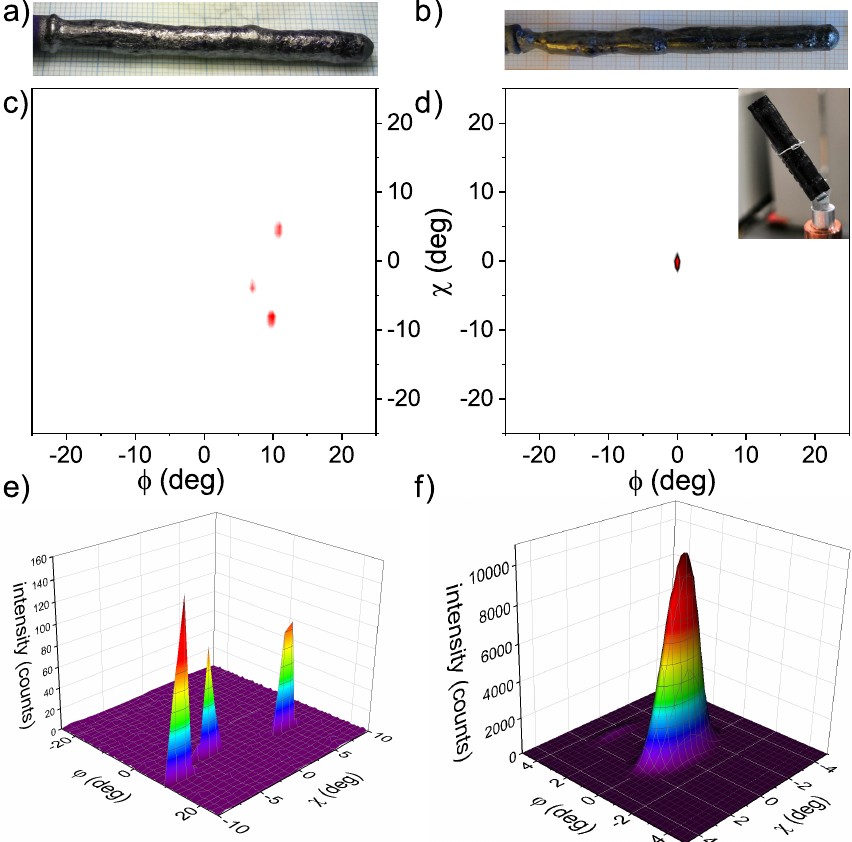
Figure 5. Comparison of crystal C6 grown with 1mm/h ( a , c , e ) and C8 0.5mm/h ( b , d , f ). Image of the floating zone grown crystal is given in (a,b) and then their neutron scattering scans of the (0 0 4) reflection plotted versus two rotation angles. First, a contour plot in (c,d) shows a larger area displaying the amount of grains and second, a 3D surface plot in (e,f) reveals the detailed